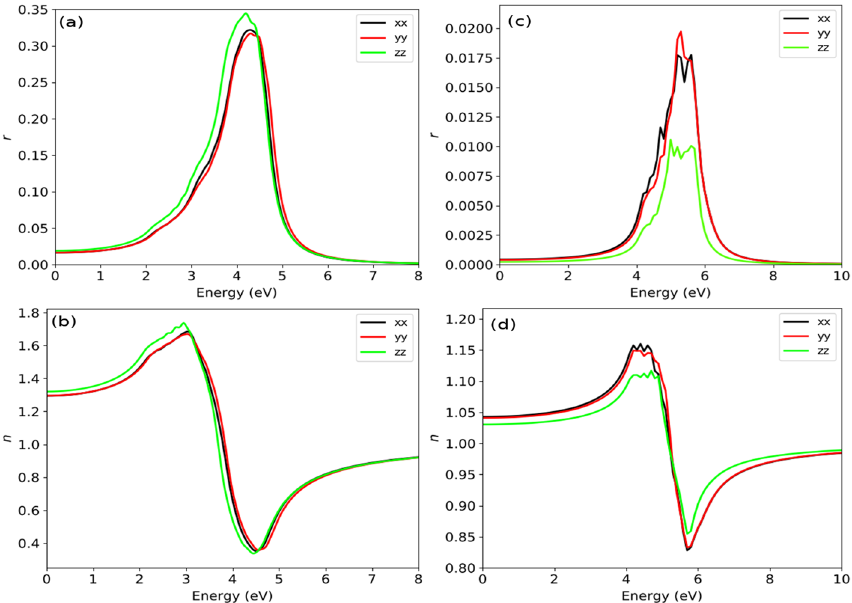
Figure 9. ( a ) Reflectivity (r) of bulk, ( b ) Refractive index ( n ) of bulk, ( c) Reflectivity (r) of 001-surface, ( d ) Refractive index ( n ) of 001-surface.